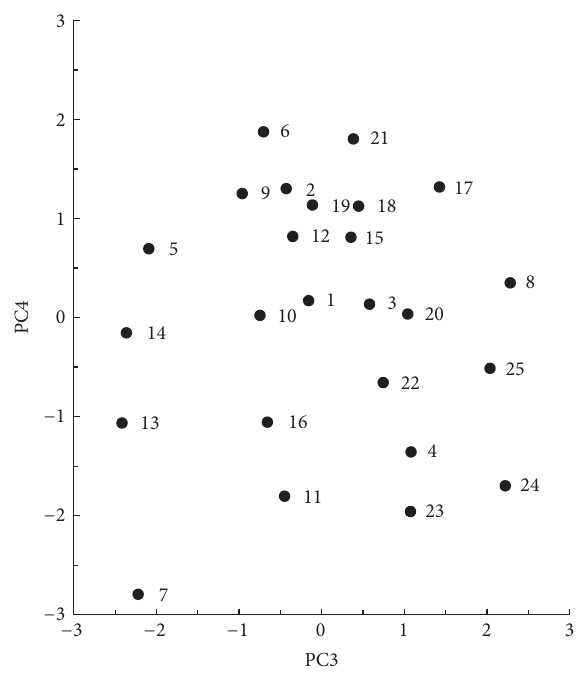
Figure 4: The score plot of samples in 3 abd 4 principal components (PC3 and